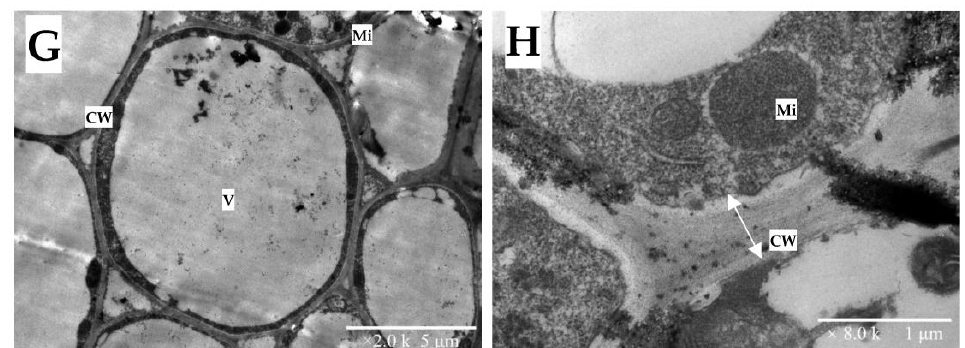
Figure 6. The TEM images of 0.5 µ M ( A , B , E , F ) and 300 µ M Cu-treated ( C , D , G , H ) roots of two citrus species. C. sinensis : ( A – D ); C. grandis : ( E – H ). CW: cell wall; Cyt: cytoplasm; ER: endoplasmic reticulum; Mi: mitochondrion; PL: plasmalemma; V: vacuole. The two-way arrow represents the average thickness of the cell wall. The scales in figures ( A , C , E , G ) represent 5 μm. The scales in figures ( B , D , F , H ) represent 1 μm.